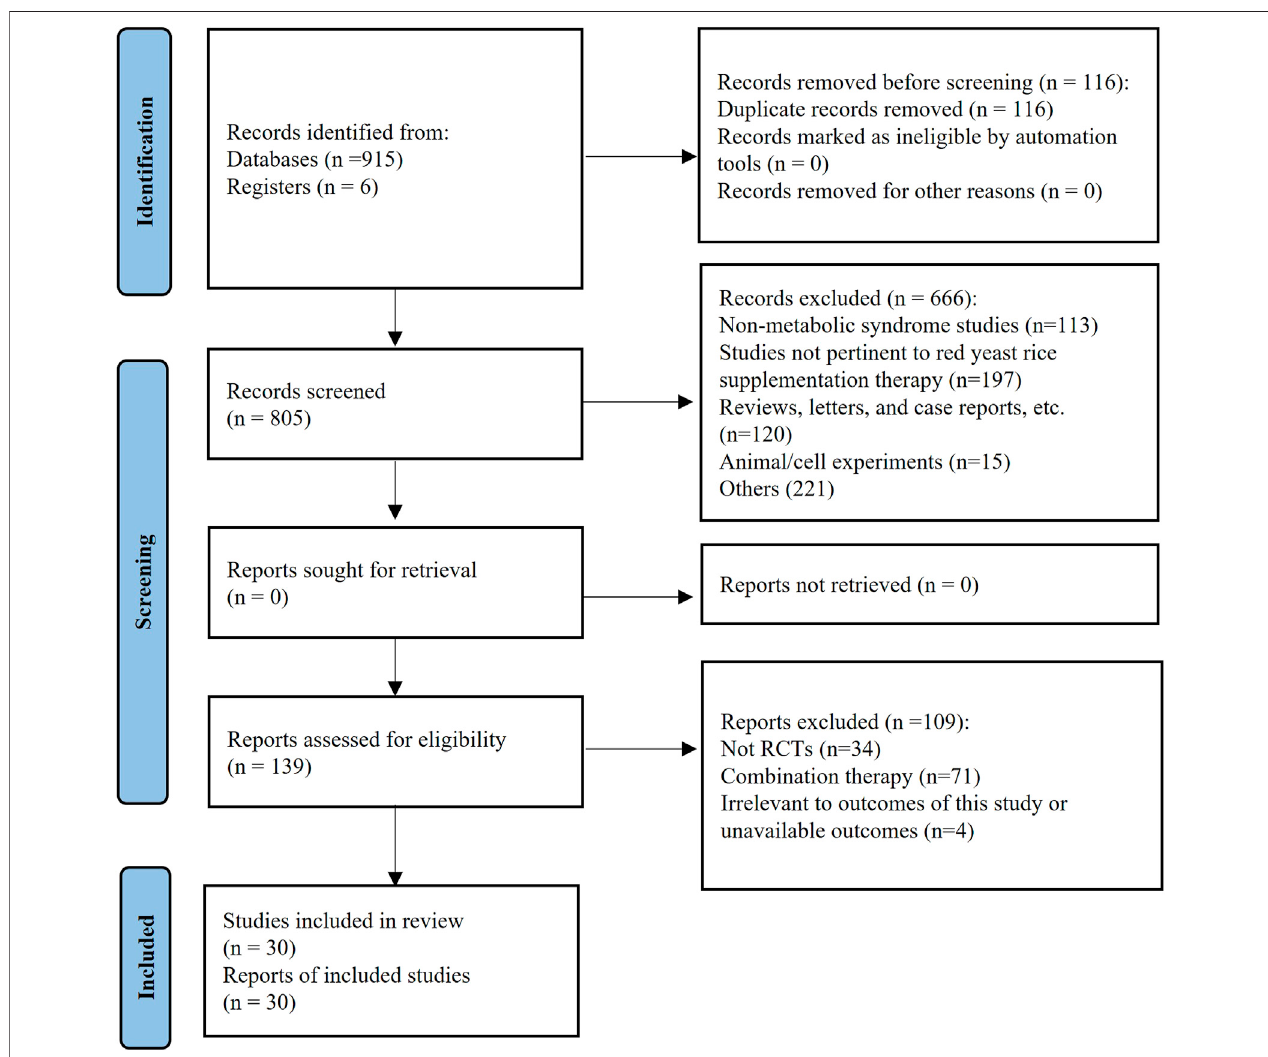
FIGURE 1 | Overview of the systematic review